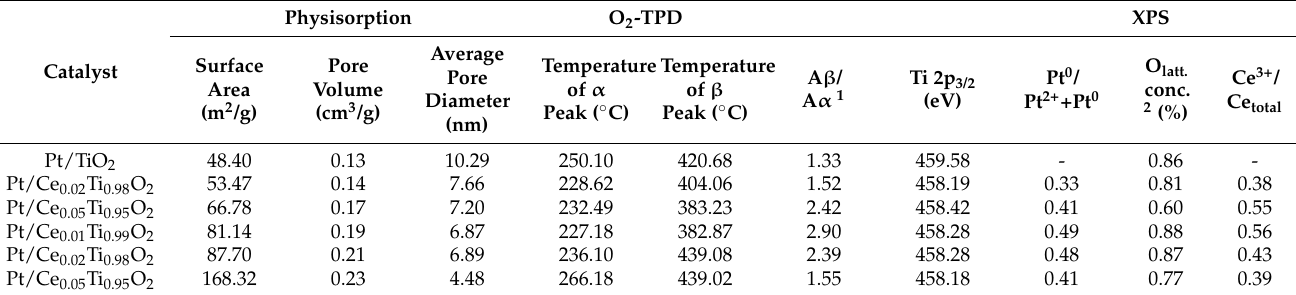
Figure 4. ( a ) Nitrogen adsorption–desorption isotherms and ( b ) pore size distribution curves of Pt/Ce x Ti 1 − x O 2 catalysts. Table 2. Specific surface areas, O 2 -TPD, and XPS results of